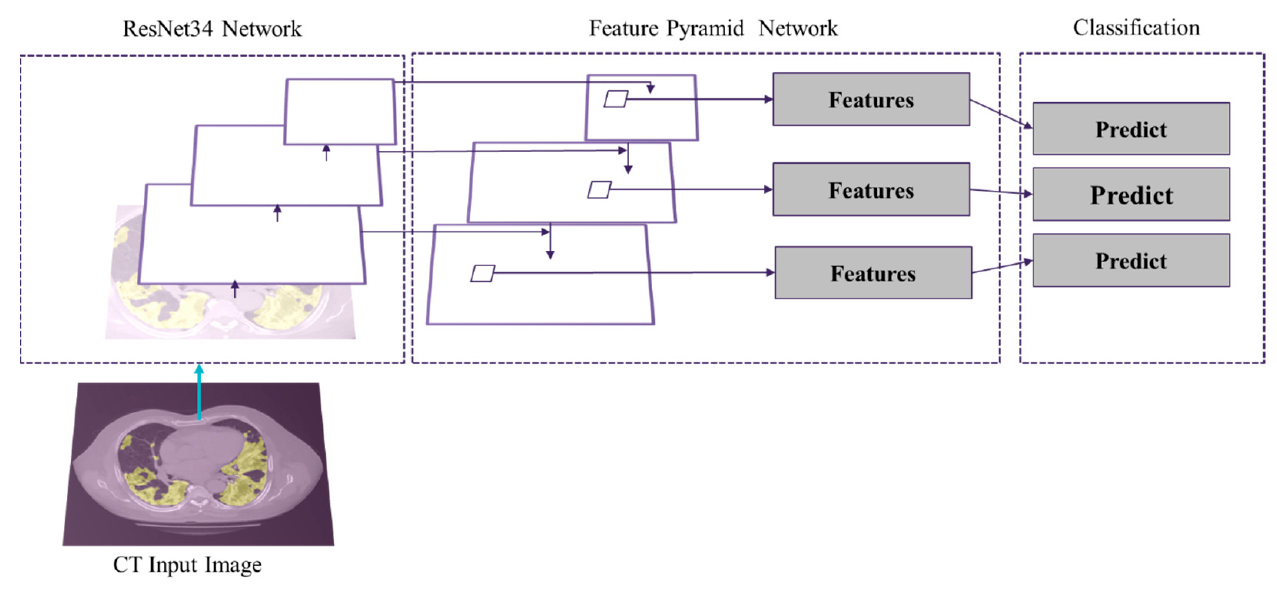
Figure 4. Overview of deep learning architecture for the patch segmentation model.